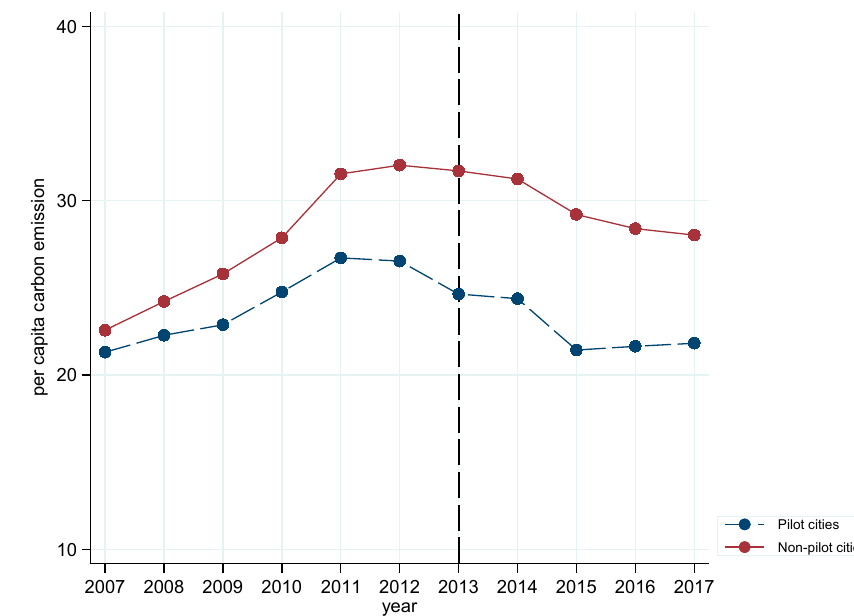
Figure 1. Annual average of per capita carbon emission.